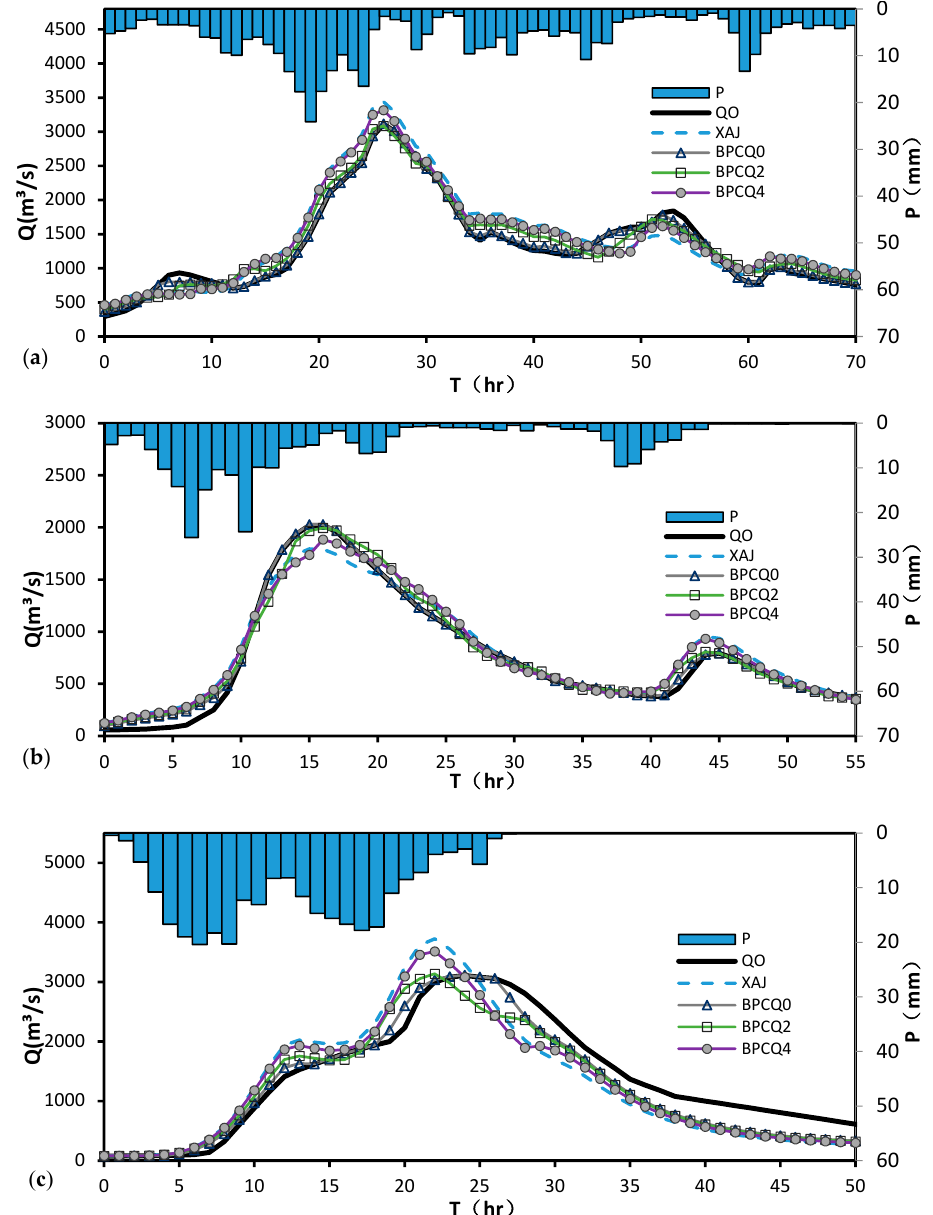
Figure 5. Single period correction performance comparison of different models: ( a ) flood 20001009 of calibration period; ( b ) flood 20050917 of validation period; and ( c ) flood 20131109 of verification period.